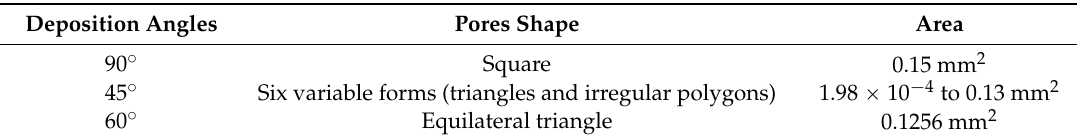
Figure 8. Scaffolds designs with different deposition angles: ( a ) 90 ° ; ( b ) 60 ° ; ( c ) 45 ° . Table 4. Pore characteristics depending on the deposition angle.